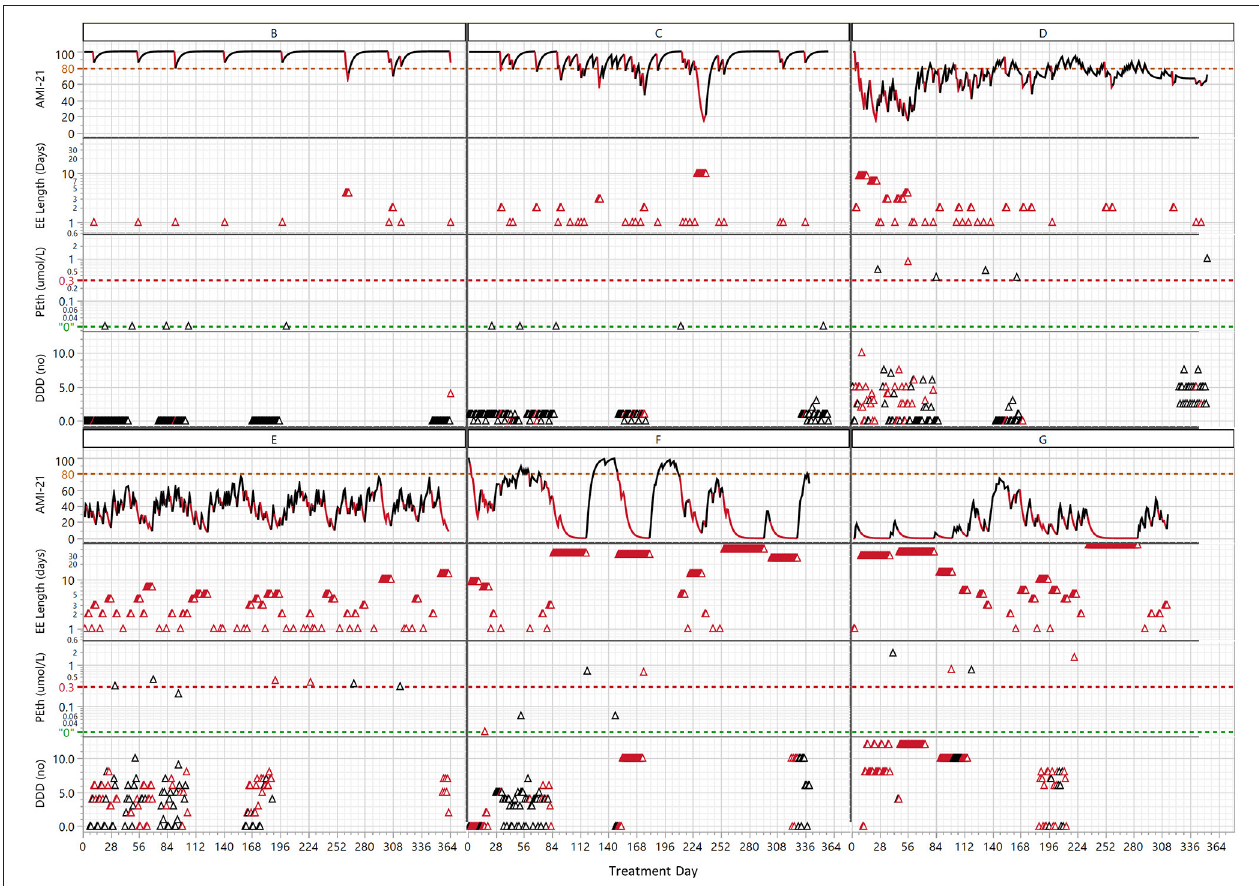
FIGURE 5 | The clinical course of the 6 patients listed in Table 1 interpreted with both the digital biomarker addiction monitoring index (AMI-21) and exacerbation events (EE length) combined with the biomarker phosphatidyl ethanol (PEth) and drinks per drinking day (DDD) arranged in order of increasing average EE percentages (see Table 1 ). The red color indicates days classified with the REI as EEs. The green line at “0” denotes the analytical detection limit of PEth, and the red line at 0.3 µ mol/L is considered indicative of heavy drinking. In the EE length graph, the same total length of the EE is plotted for each day on the x-axis, i.e., a 10-day-long EE has 10 red triangles on 10 consecutive treatment